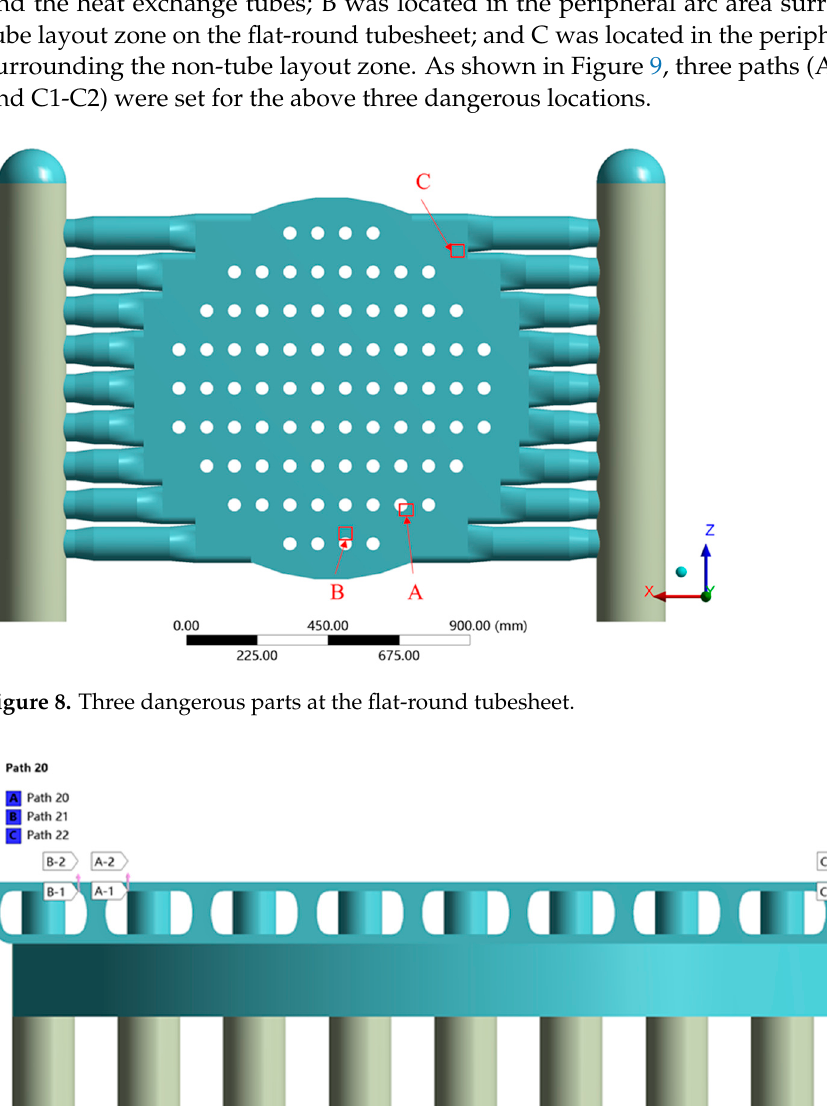
( b ) Figure 7. ( a ) Stress intensity distribution and ( b ) maximum stress on the upper flat-round tubesheet under load case 2 with 9 mm pretension of the tubes.